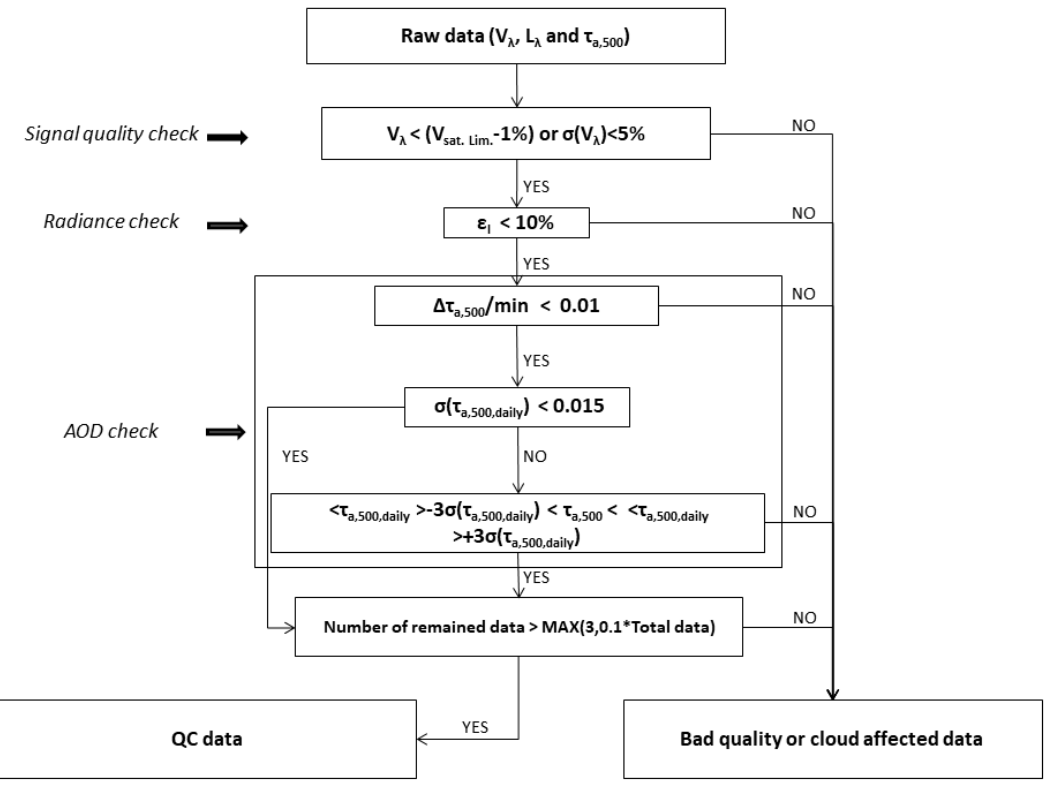
Figure 3. ZEN quality control (ZEN-QC) scheme flowchart.